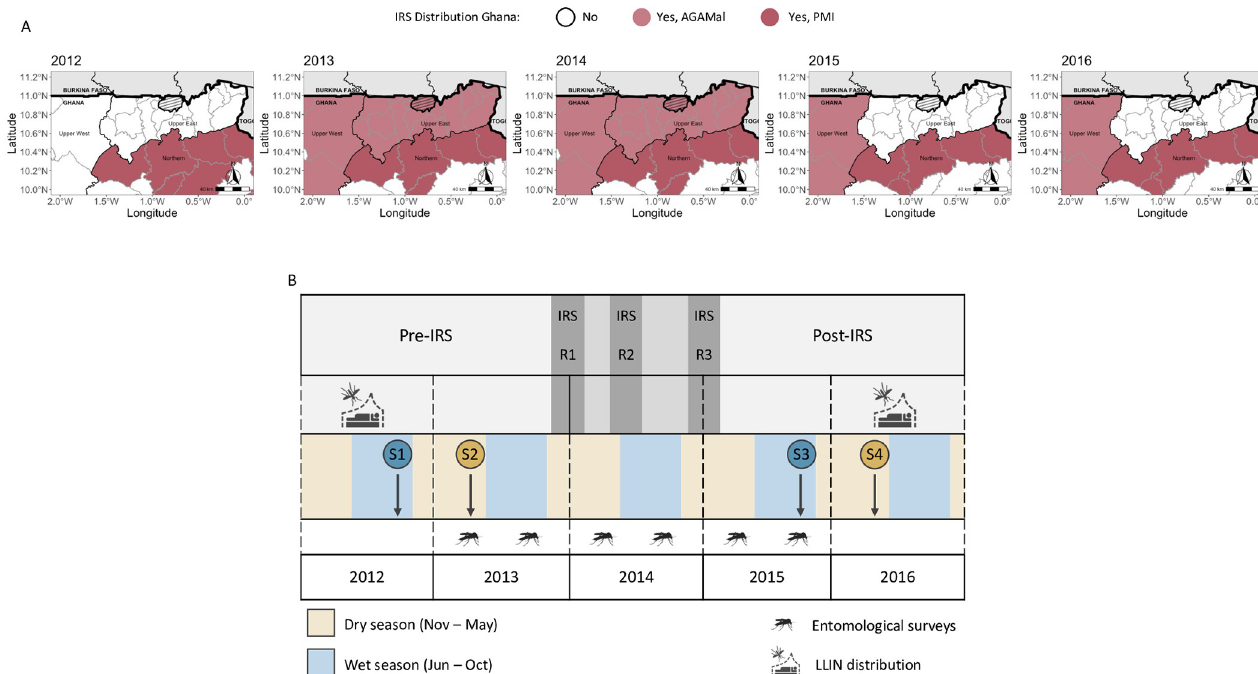
Fig 1. The IRS intervention and the Bongo study design. A. Distribution of IRS across the Upper East, Upper West, and Northern Regions of Ghana, West Africa between 2012 to 2016. Highlighted in light red are the IRS programmes funded by the Global Fund in partnership with the AGAMal (Upper East and Upper West Regions) and in dark red are those funded by PMI/AIRS (Northern Region). Districts where no shading is indicated, denote no ongoing IRS programmes during the study time period. Bongo District, where the current study took place, is denoted by the black hashed lines. The thick black lines are used to signify borders between Ghana and Burkina Faso (light grey) to the north, and Ghana and Togo (light grey) to the west. This map was drawn in R using the rnaturalearth package (https://github.com/ropensci/rnaturalearth) and data from Natural Earth (http://www.naturalearthdata.com/) under a CC0 license, with district-level data from the Malaria Atlas (https://github.com/malaria-atlas-project/malariaAtlas) available in an open-access repository. B. Four age- stratified cross-sectional surveys (N = ~2,000) were conducted in Bongo at the end of the wet (blue circles) and the end of the dry seasons (gold circles) between October 2012—June 2016. The study design can be broken down into two study phases: (1) Pre-IRS: two surveys prior to the introduction of IRS (Survey 1 October 2012 (S1); Survey 2 May/June 2013(S2)); and (2) Post-IRS: two surveys following three-rounds of IRS (Survey 3 October 2015 (S3); Survey 4 May/June 2016 (S4)). The three-rounds of IRS were implemented between 2013–2015 as indicated with grey shading: Round 1 (R1: October 2013 –January 2014, Vectoguard 40WP), Round 2 (R2: May–July 2014, Actellic 50EC), and Round 3 (R3: December 2014 –February 2015, Actellic 300C). LLINs were mass distributed in Bongo District using universal coverage campaigns between 2010–2012 and again in 2016 as indicated. The mosquitos are used to denote when the monthly entomology surveys were undertaken (February 2013 and September